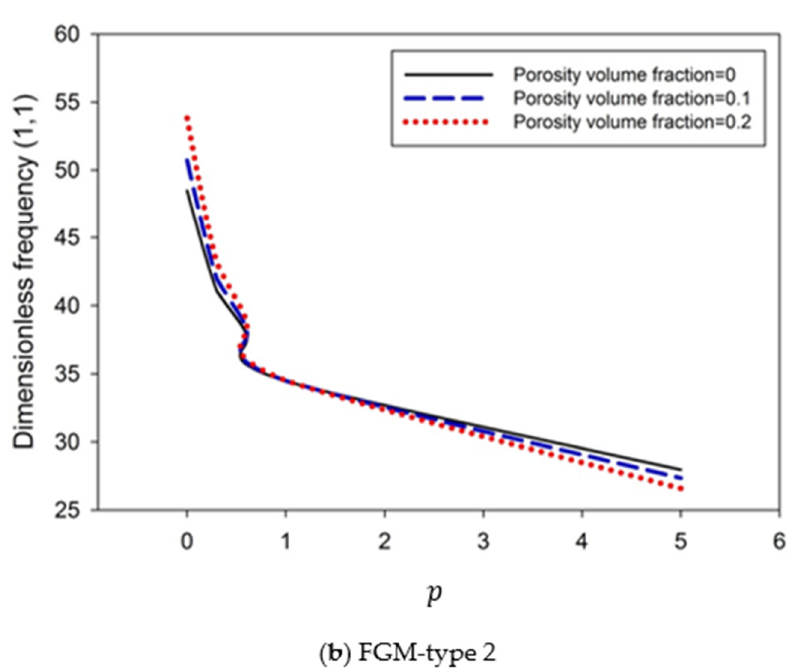
Figure 9. Dimensionless frequency of FG porous circular cylindrical shell versus different power-law indices for various porosity volume fractions: ( a ) FGM ‐ type 1; ( b ) FGM ‐ type 2.